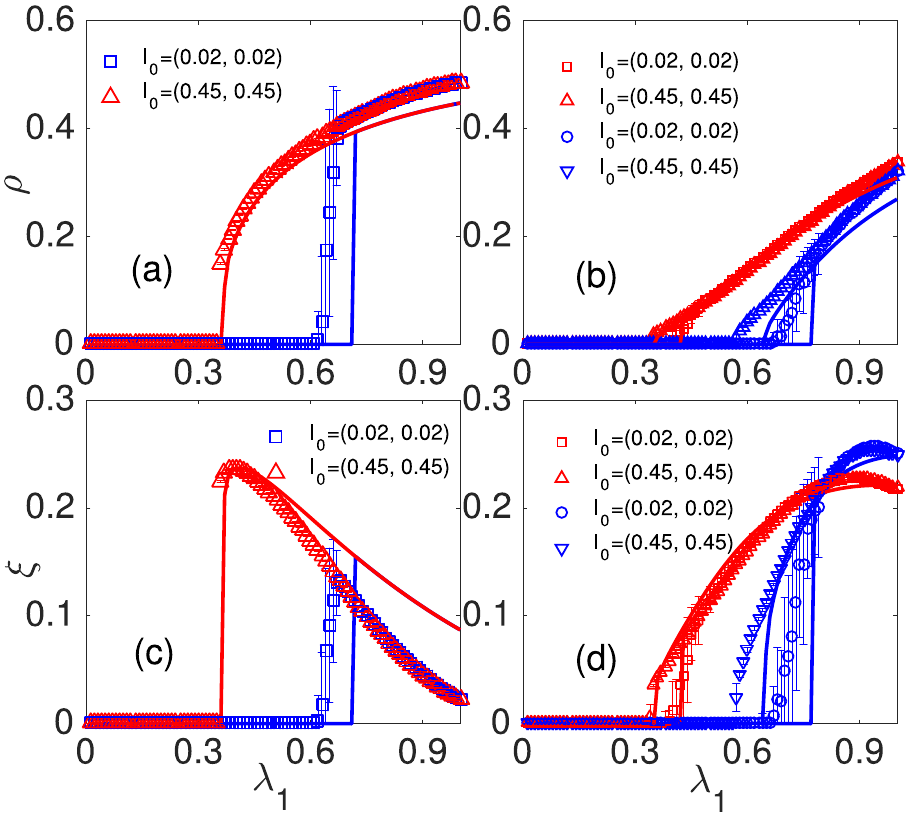
Figure 4. The numerical simulation results of the final adoption size ρ ( a , b ) and trial size ξ ( c , d ) versus different (cid:31)(cid:30) values of λ 1 with θ = ( ◽ , ○ ) and = . . I (0 45, 0 45) ( Δ , ∇ ). In ( a ) and ( c ), social (4, 2, 1) , = . . I (0 02, 0 02) 0 0 contagions on ER networks. In ( b ) and ( d ), social contagions on SF networks with τ = 2.5 ( ◽ and Δ ) and τ = 3.0 ( ○ and ∇